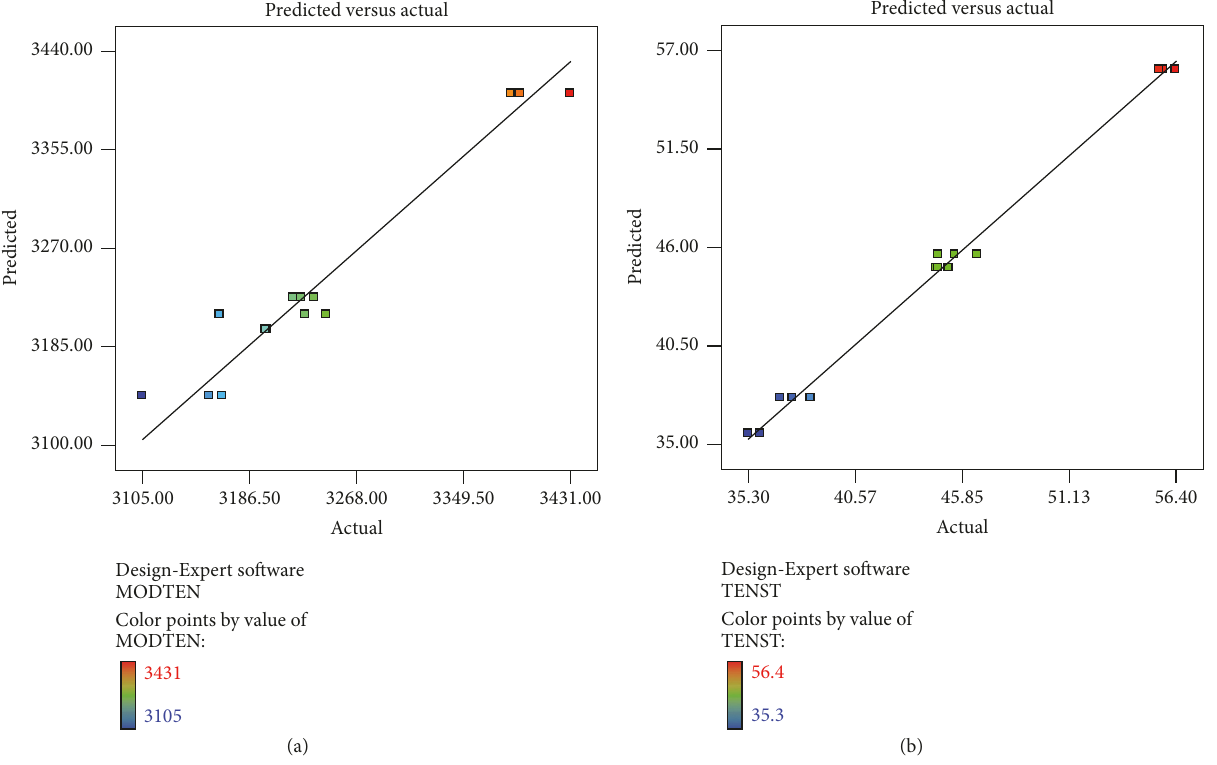
Figure 5: Predicted versus experimental data for tensile mechanical properties.